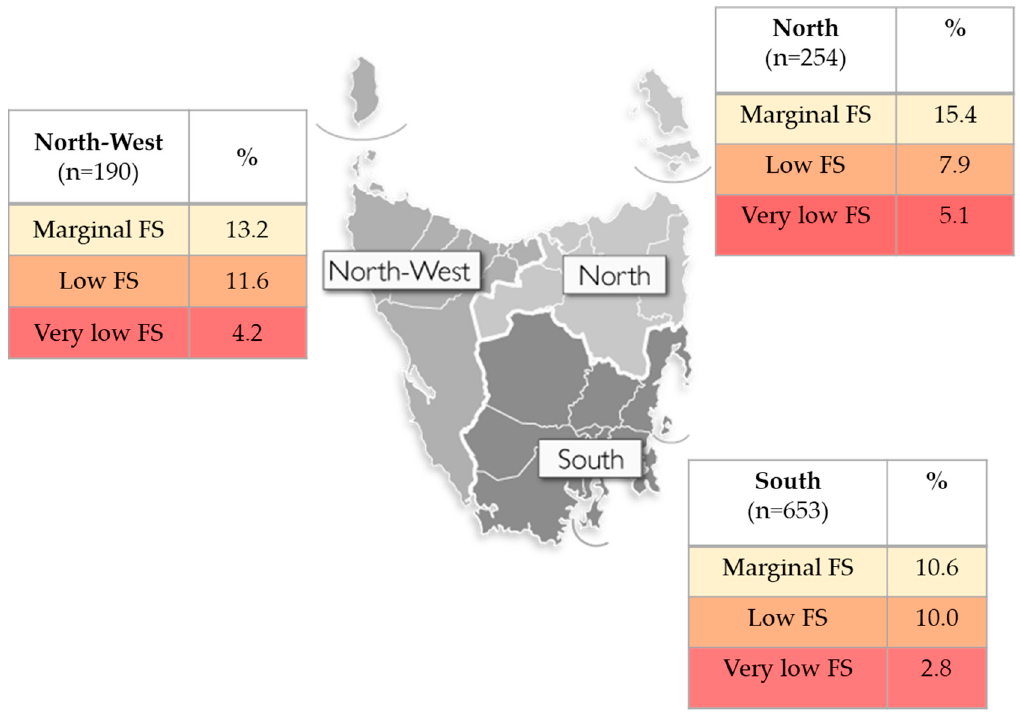
Figure 1. Prevalence of Marginal, Low and Very Low Security by region in Tasmania, Australia (map sourced from Department of Health and Human Services Tasmania: http://www.dhhs.tas.gov.au/tho). FS—Food